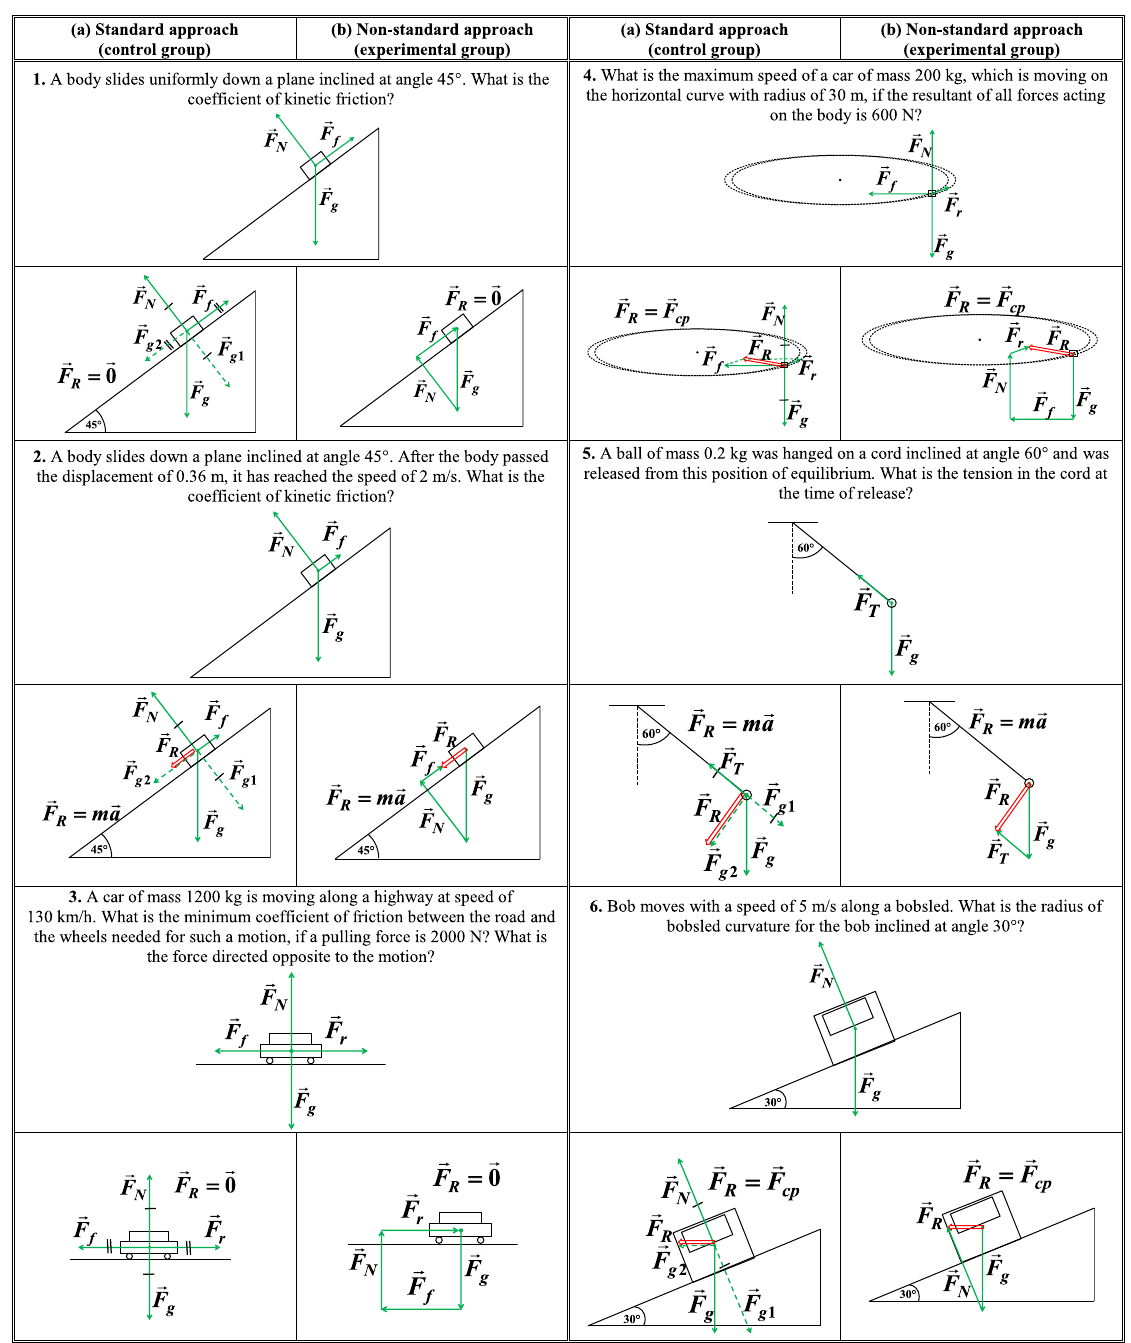
FIG. 5. Physics problems solved in class. For each of the six physics problems given in the Table, the standard (a) and nonstandard (b) approach to drawing FBDs is shown. Forces are drawn as simple arrows, components of forces as dashed arrows, and the resultant force as a double-line arrow. Pairs of vectors that cancel out are marked by single or double bars on the